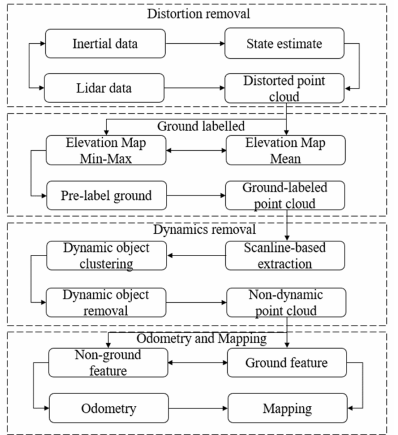
Figure 1. Algorithm